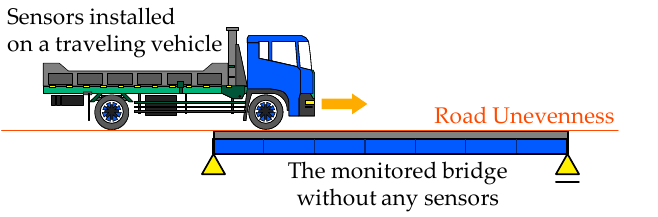
Figure 1. The conceptual diagram of the drive-by bridge monitoring: The measured vibration data on a traveling vehicle is used to evaluate the bridge’s health. In this study, bridges are modeled as simple Euler–Bernoulli beam supported by pins.